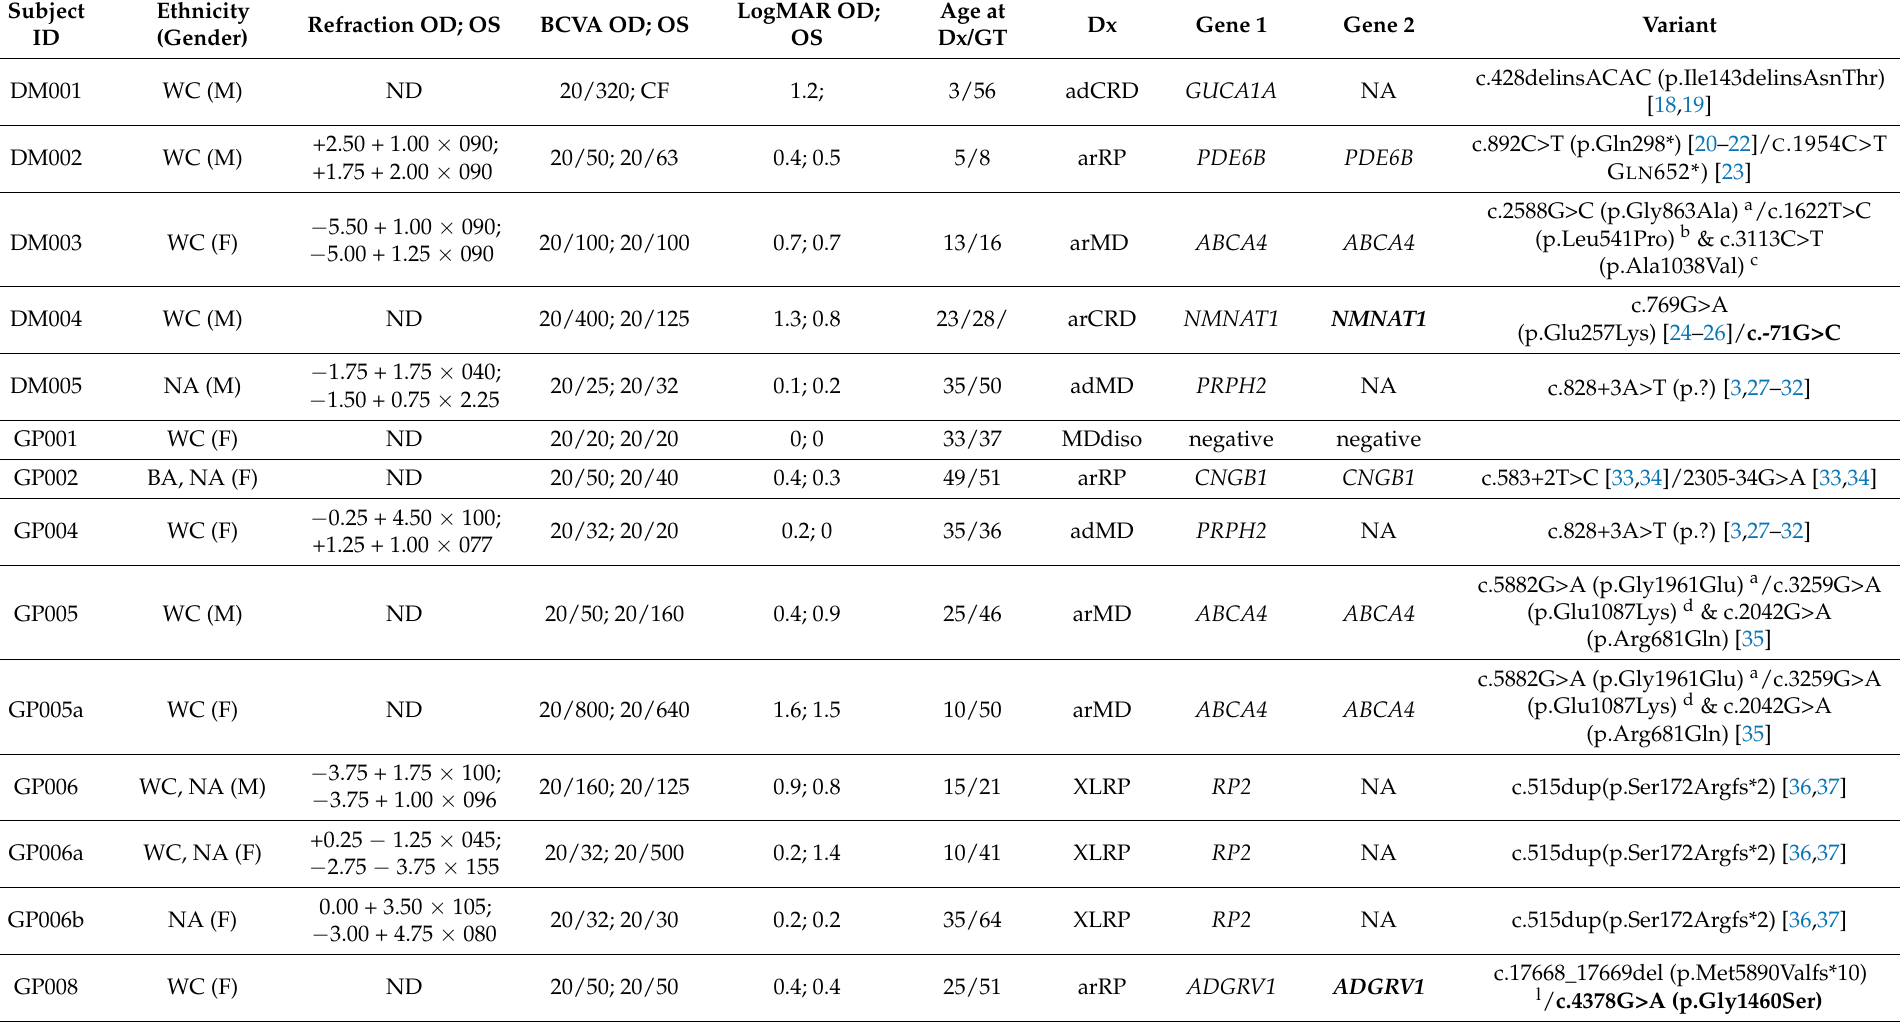
Table 1. Patient